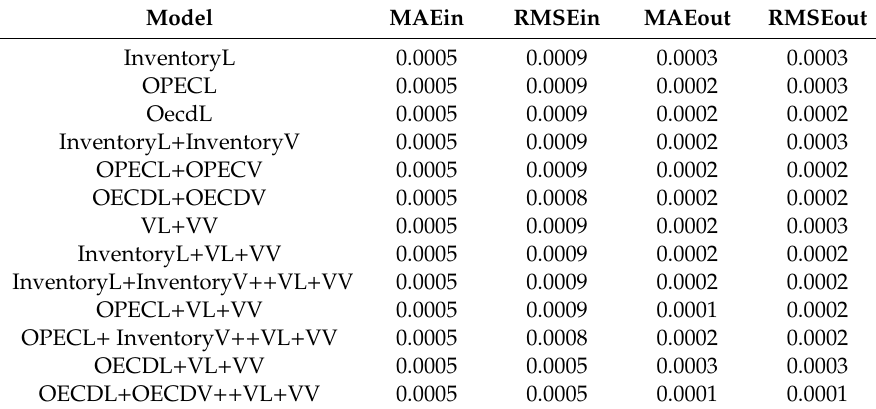
Table 13. Predicted parameter estimation results for each